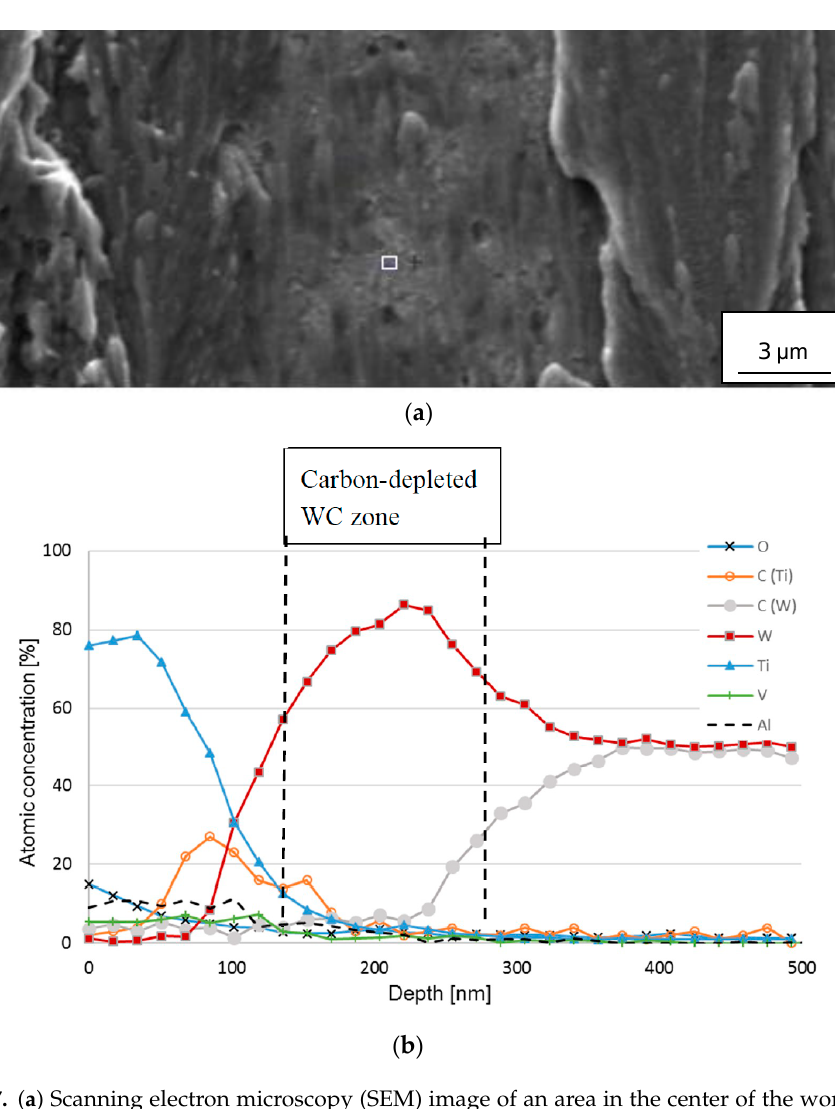
Figure 7. ( a ) Scanning electron microscopy (SEM) image of an area in the center of the worn crater (cutting speed: 90 m/min). ( b ) Auger electron spectroscopy (AES) depth profile obtained from the indicated area.